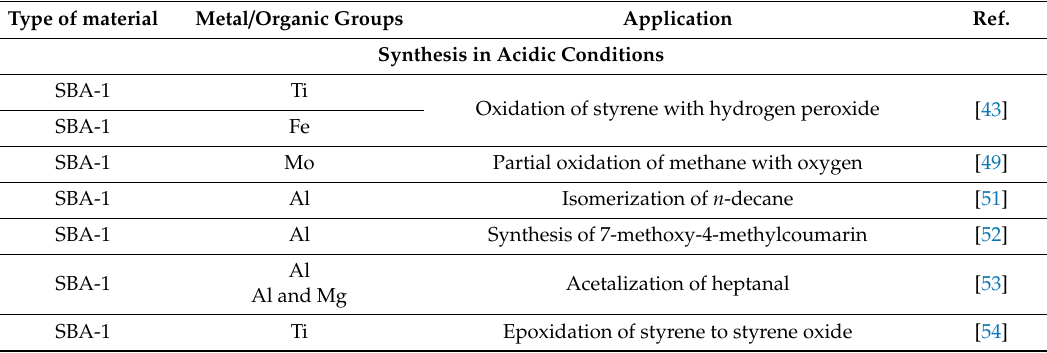
Table 2. Potential use of the SBA and HMM-type